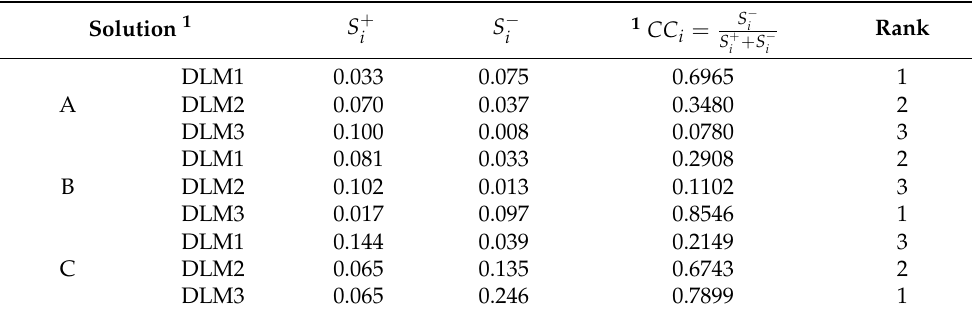
Table 13. Distance from positive and negative ideal solutions.